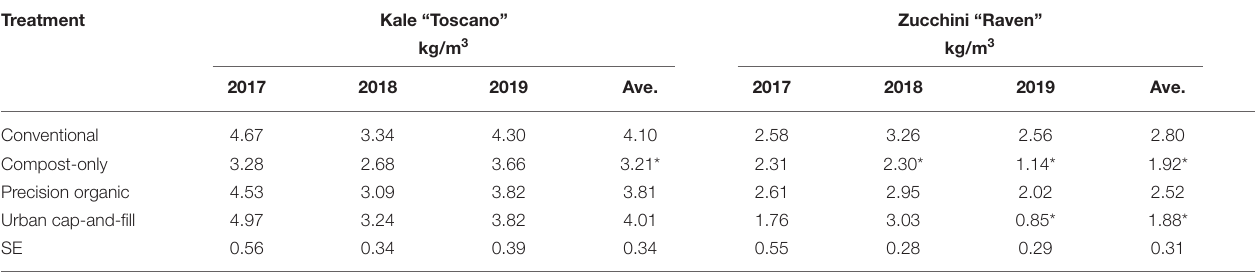
TABLE 4 | Marketable yields for two core crops by year and pooled across years due to an insignificant ( p > 0.05) treatment-by-year interaction. Treatment